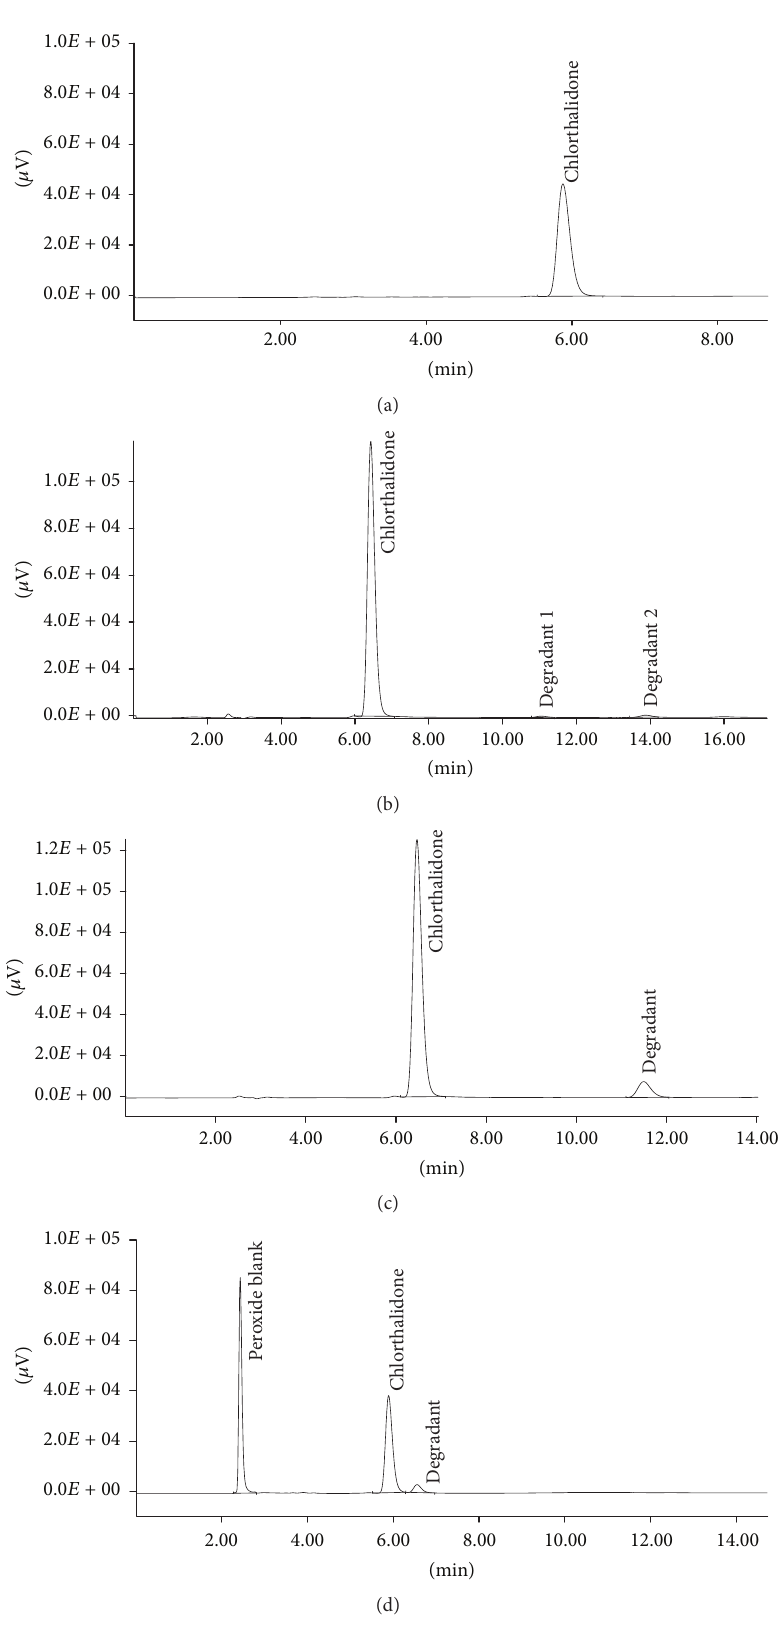
Figure2:(a)Representativechromatogramofunstressedchlorthalidone.(b)Representativechromatogramofacidtreatedchlorthalidone.(c) Representative chromatogram of alkali treated chlorthalidone. (d) Representative chromatogram of oxidative degradation of